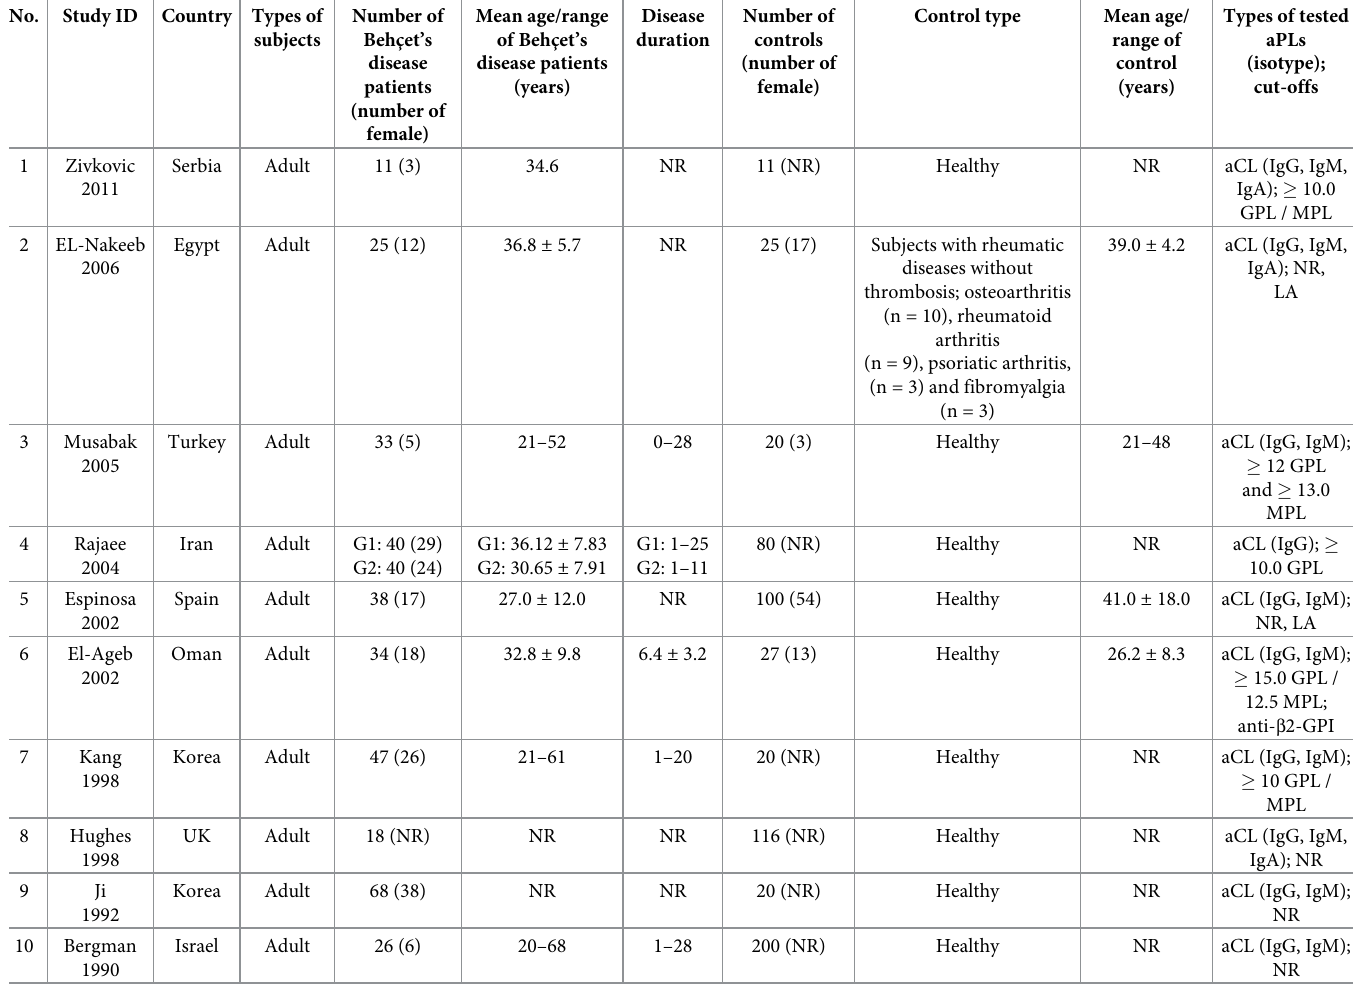
Table 1. Major characteristics of the included studies in this